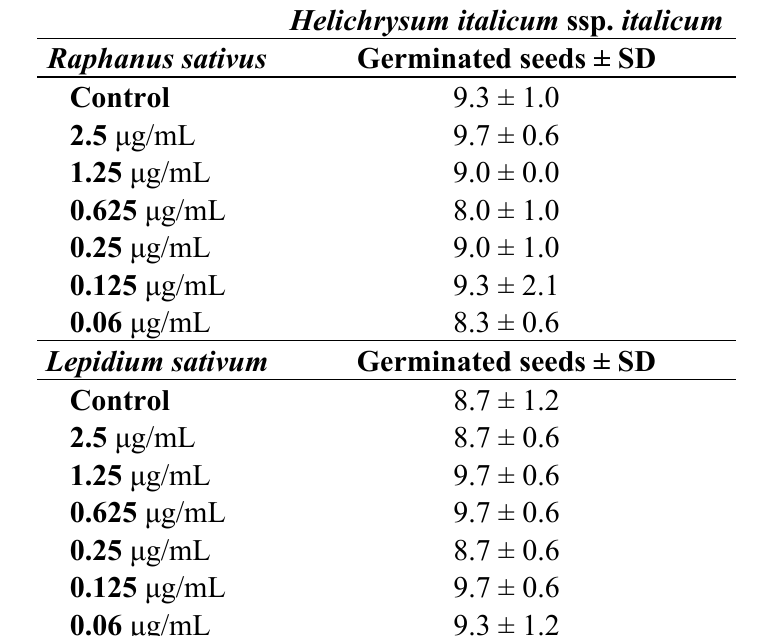
Table 2. Biological activity of essential oil of Helichrysum italicum spp. italicum against germination of Raphanus sativus (radish) and Lepidium sativum (garden cress), 120 h after sowing. Results are the mean ± standard deviation (SD) of three